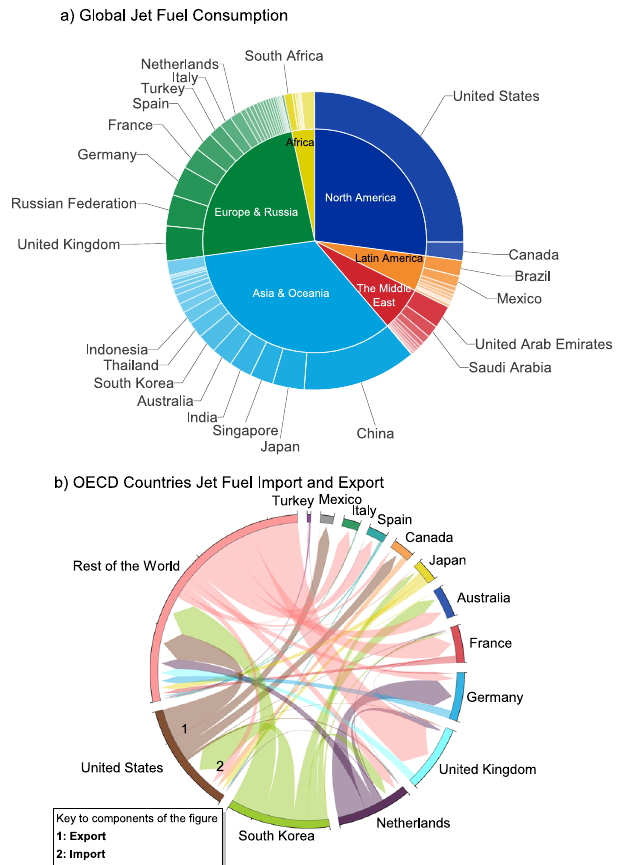
Fig. 1 | Global jet fuel market in 2017. a Global jet fuel consumption in 2017 (in barrels per day) by country and region. The inner pies are annual jet fuel con- sumption in percentage by world region. The outer arcs are annual jet fuel con- sumption in eachcountry. The greater the arclength,the higher the consumption. The Middle East includes Iran, Saudi Arabia, UAE, Iraq, Qatar, Kuwait, Oman, Bah- rain, Syria, Jordan, Lebanon, and Yemen. North America, Asia & Oceania, and Eur- ope&Russiaaccountforover85%ofglobaldemand,withtheUS(25%),China(12%), and the UK (3.8%) topping the list. The remaining demand is spread across devel- oped countries globally. The US (25%), China (13%), and South Korea (7%) are the top three producers. b Key Organisation for Economic Co-operation and Devel- opment (OECD) countries ’ annual jet fuel import and export. Countries are represented by outer segments arranged along the circle. Segment length is determined by the sum of export and import (from left to right of each segment, seetheUSexample),whicharedepictedbyarcsdrawnbetweensegments.Thesize of the arc is proportional to the weight of the fl ow. The arrowhead shows the directionofexport.KeycountriesincludedintherestoftheworldareChina,India, Singapore, and Russia. Their exports are 7.8%, 8.2%, 8.4%, and 2.6% of the global export, whereas their imports are 4.4%, 0.3%, 3.7%, and 0.1% of the global import, respectively 62